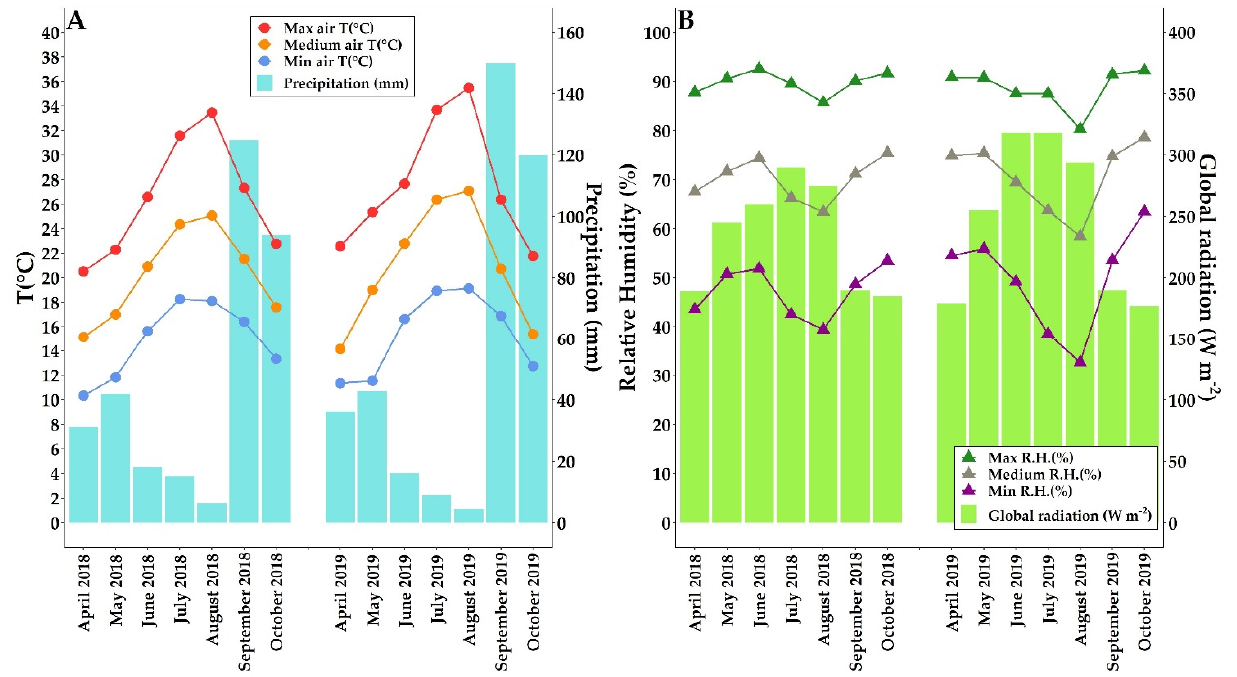
Figure 1. Climatic conditions of the experiment location. Monthly averages of mean, maximum, minimum air temperature (°C) and total monthly rainfall (mm) ( A ) were measured from April to October (2018–2019); monthly averages of mean, maximum, minimum relative humidity (%), and average monthly global radiation (RAD, W m ⁻ 2 ) ( B ) were measured from April to October (2018–2019).